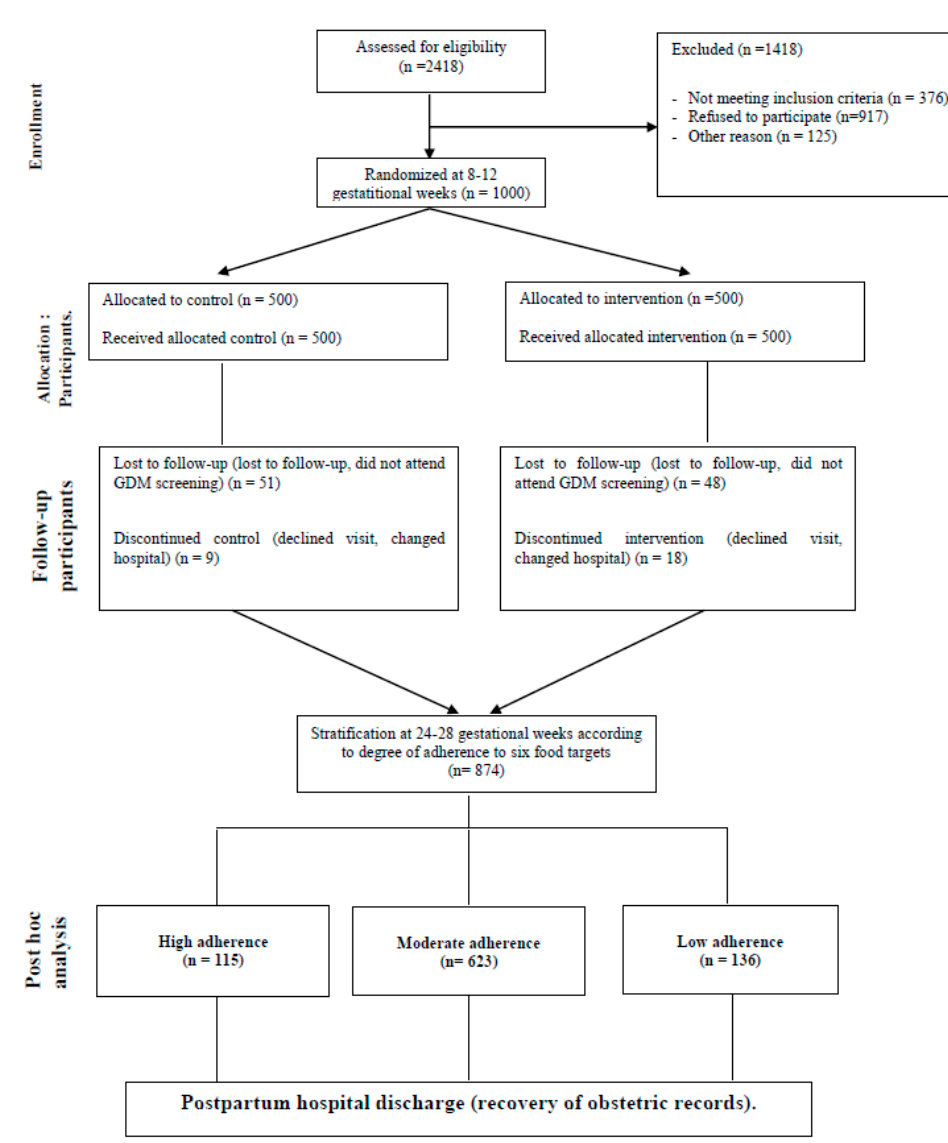
Figure 1. Flow diagram showing a summarized description of the study design, and the women analyzed for this post hoc analysis of the St. Carlos gestational diabetes mellitus (GDM)